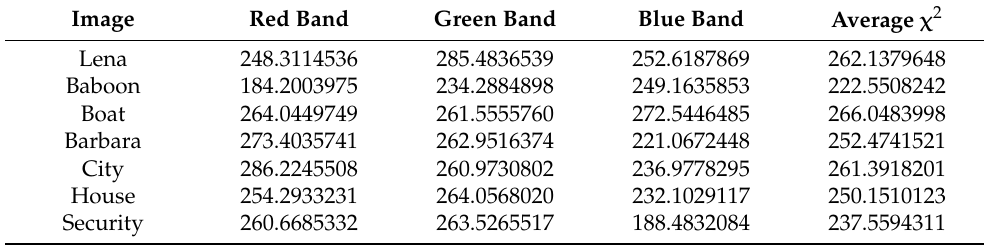
Table 7. χ 2 test